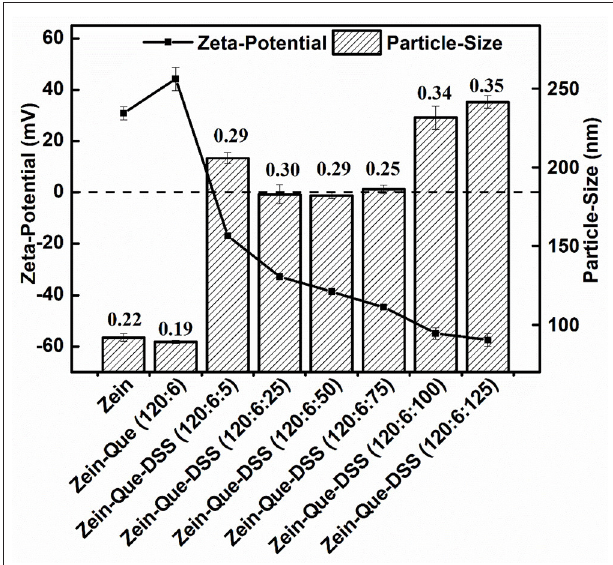
FIGURE 1 | Particle size and zeta potential of Zein, Zein-Que, and Zein-Que-DSS complex nanoparticles, and therein the numbers represent the polydispersity index (PDI) of obtained colloidal particles.